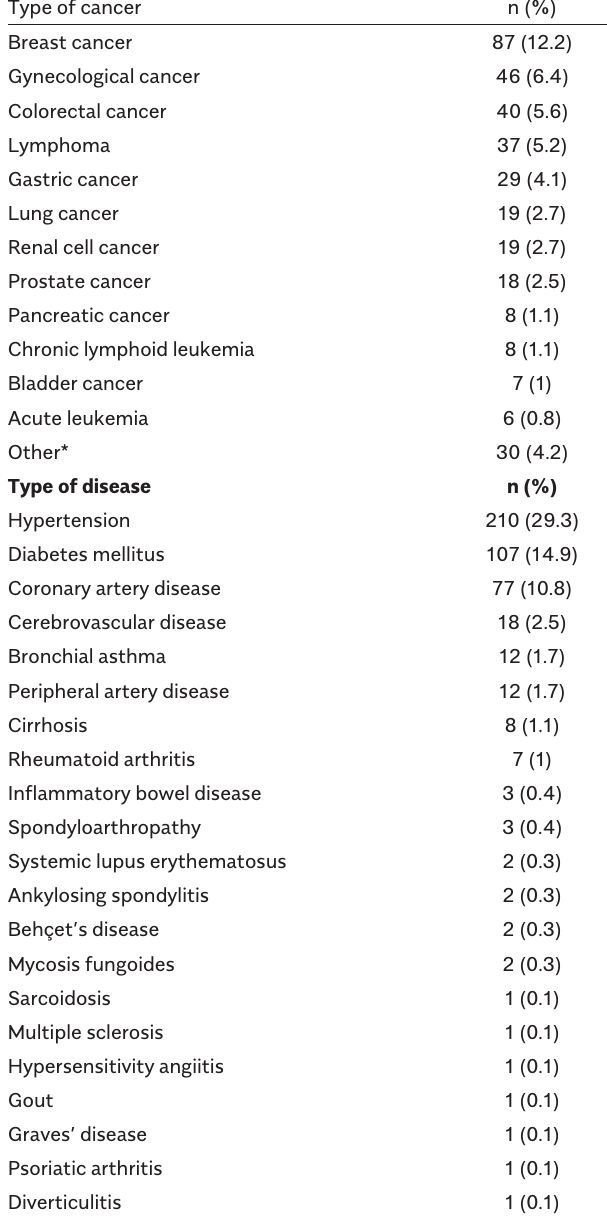
and colorectal cancer (5.6%). In addition, 24.4% of malignancies were located in the intra-abdominal region (Table 2). Table 2. Malignant and Nonmalignant Diseases in Patients with Mesenteric Panniculitis Type of